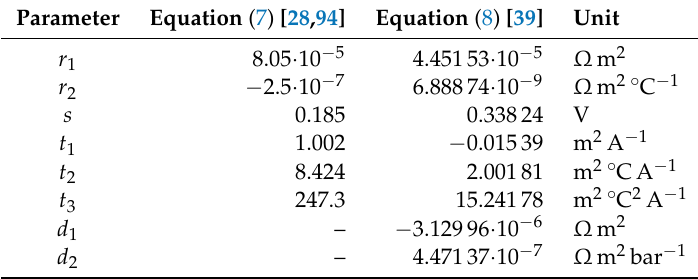
Table A1. Parameters for the calculation of cell voltage by Equations (7) and (8)